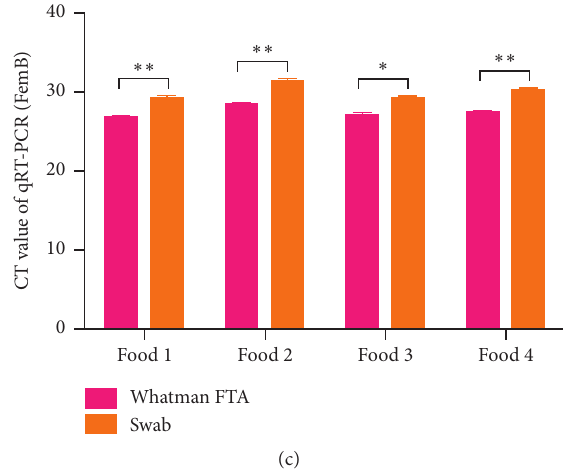
Figure 7: CT values of the Staphylococcus aureus gene in Whatman FTA Elute cards are higher than those on swabs. (a) Expression of the Staphylococcus aureus gene FemB in samples collected using Whatman FTA Elute cards detected by RT-qPCR ( n � 6, ∗ P < 0 . 05, ∗∗ P < 0 . 01, and ∗∗∗ P < 0 . 001). (b) Expression of the Staphylococcus aureus gene FemB in samples collected using swabs detected by RT-qPCR ( n � 6, ∗ P < 0 . 05 and ∗∗ P < 0 . 01). (c) Expression level of the FemB gene in an environmental strain of Staphylococcus aureus samples on Whatman FTA cards and swabs detected by RT-qPCR ( n � 6, ∗ P < 0 . 05 and ∗∗ P < 0 . 01). RT-qPCR: reverse transcription-quantitative PCR; FTA: Flinders Technology